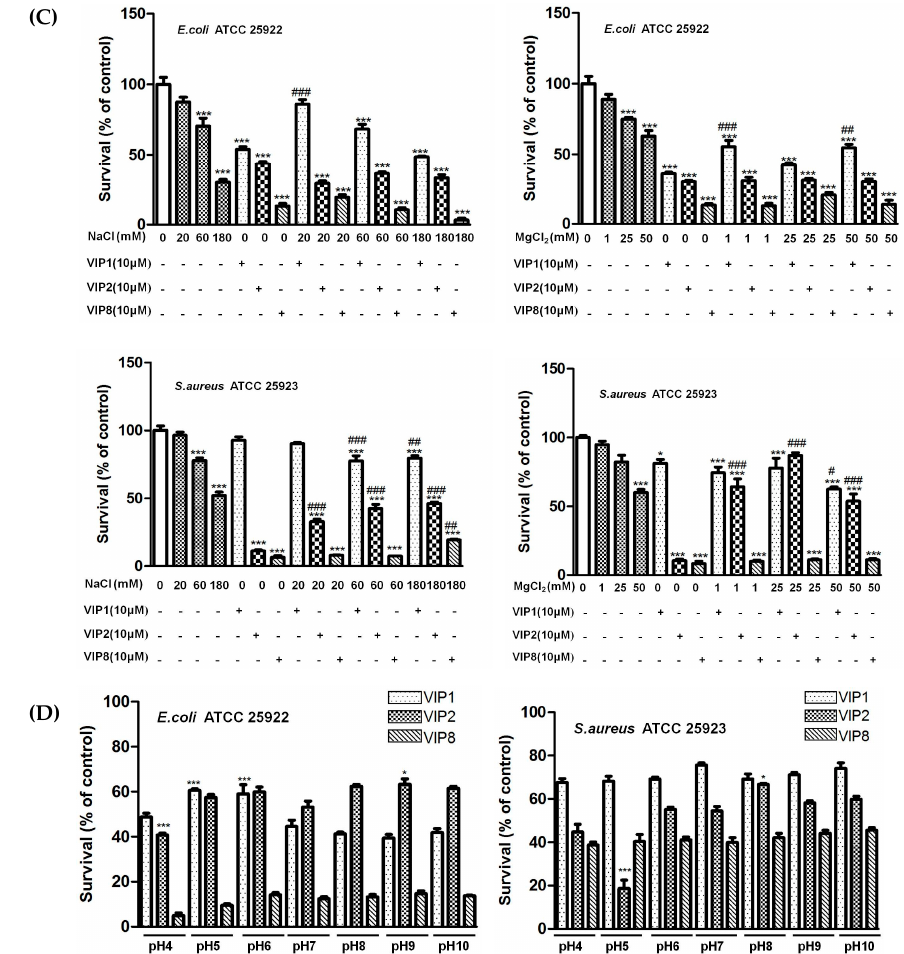
Figure 2. Haemolytic activity of VIP and VIP analogues against pRBCs ( A ), the cytotoxicity of natural VIP (VIP1) and VIP analogue 8 against 3T3-L1 cells ( B ), and effect of the ionic strength ( C ) and pH ( D ) of the medium on the activity of natural VIP (VIP1) and VIP analogue against E. coli and S. aureus . Bacteria were incubated with VIP1, VIP2, and VIP8 at the concentration of MIC in the absence or presence of different concentrations of NaCl or MgCl 2 for 3 h. ( C ) * P < 0.05 and *** P < 0.001 versus peptide-treated bacteria; # P < 0.05, ## P < 0.01, and ### P < 0.001 versus untreated bacteria at each condition. ( D ) * P < 0.05 and *** P < 0.001 versus controls at each pH; # P < 0.05, ## P < 0.01 and ### P < 0.001 versus peptide-treated bacteria at pH 7.0. All data were present as the mean ± SEM ( n = 4).